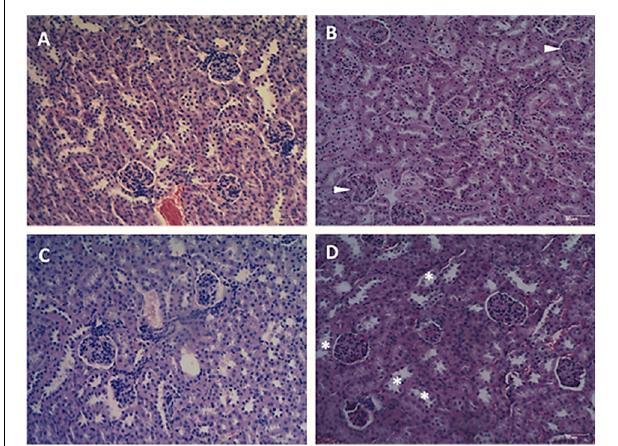
FIGURE 9 | Photomicrographs of the renal cortex of mice after 10 days of treatment with Fluopsin C or placebo. The control group (A,C) presented mild inflammatory infiltrate and bleeding in the glomerular corpuscles. In the tubules (C) , discrete cytoplasmic vacuolation could be observed and scaling was practically non-existent. The animals in the treated group (B,D) presented no glomerular changes (arrowheads), but a mild peeling of the tubular epithelium (asterisk) was detected. Similar images were observed in other fields and on other days. Color: HE. Scale bar: 25 µ